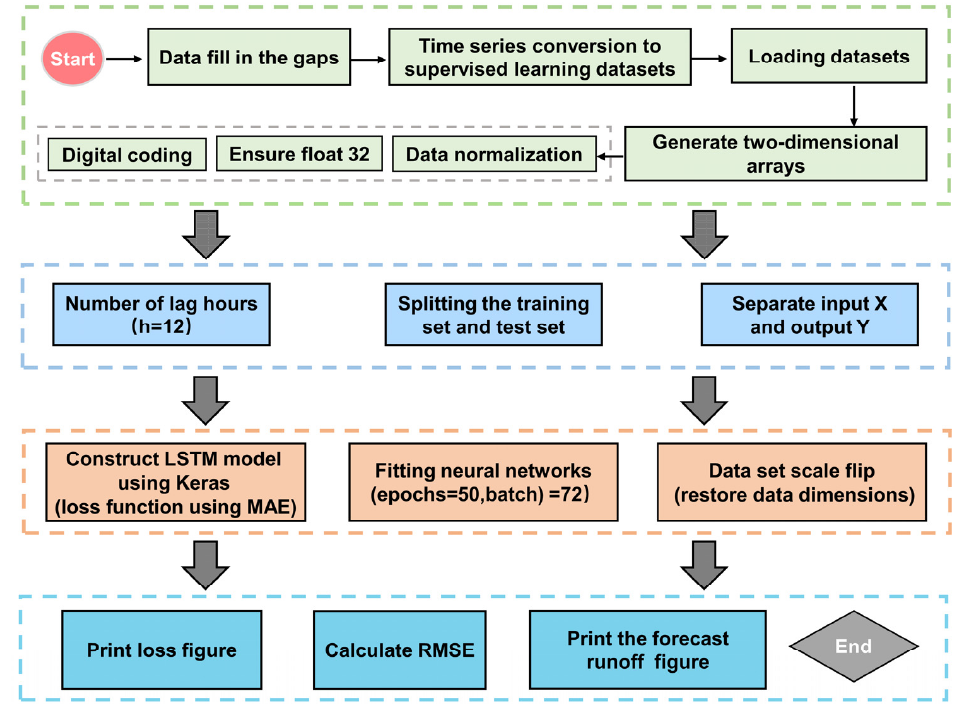
Figure 5. Running process of LSTM model.